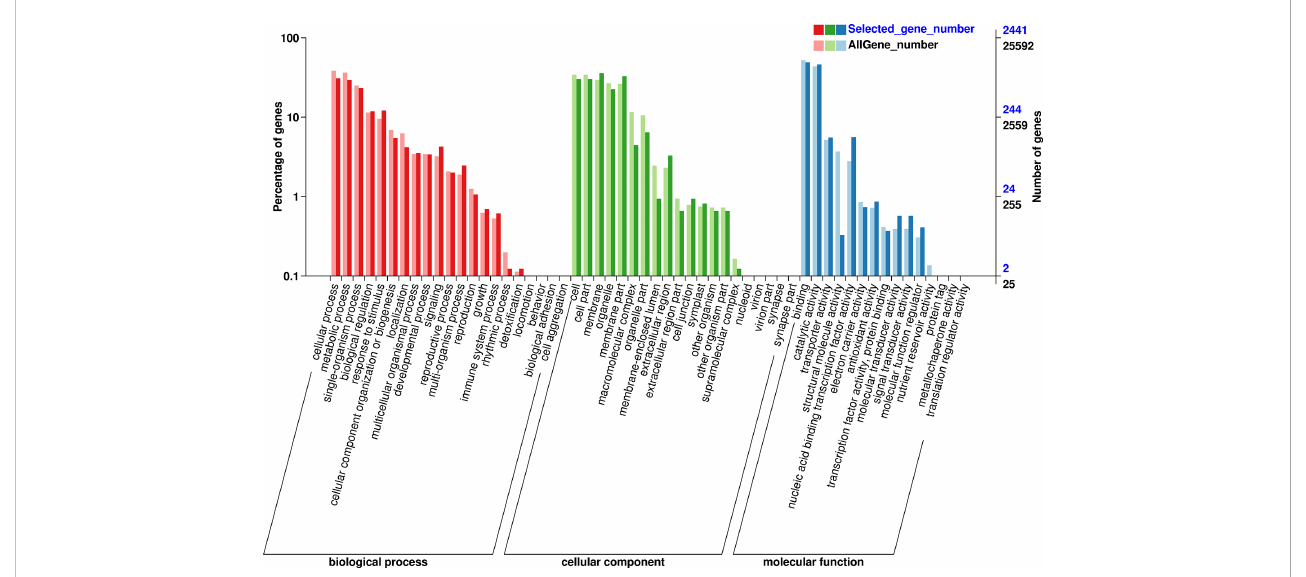
FIGURE 9 Gene ontology (GO) enrichment analysis of DEGs. GO classi fi ed as BP, CC, and MF.